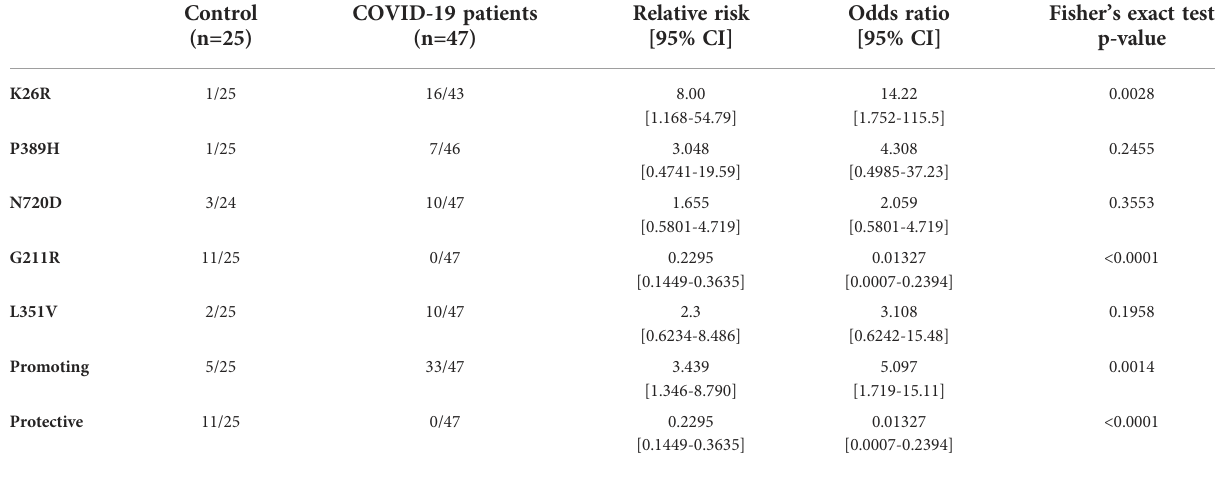
TABLE 3 Infection-promoting ACE2 polymorphisms are risk factor for COVID19 susceptibility in a 72-patient